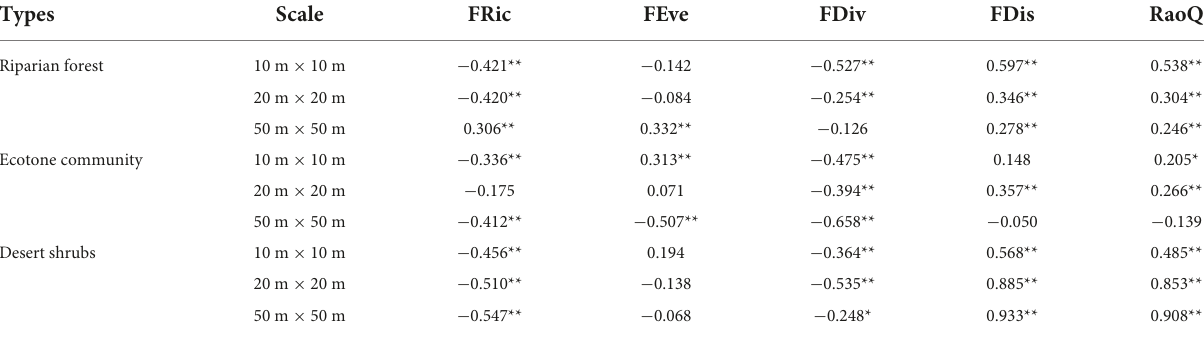
TABLE 1 Relationship between functional diversity and community